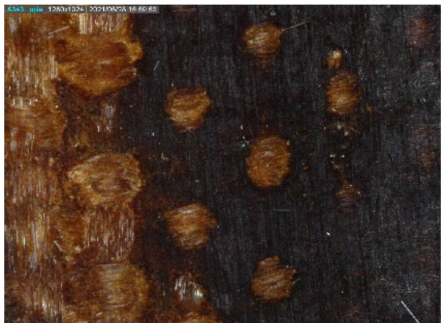
Figure 13. MO image of the surface of the textolite material with intensified degradation effects (40 times magnification). The edge part of the textolite element is visible, in which a strong charring and burning out of a fragment of the top layer of the resin took place. On the left side, at the edge, the exposed textile support is